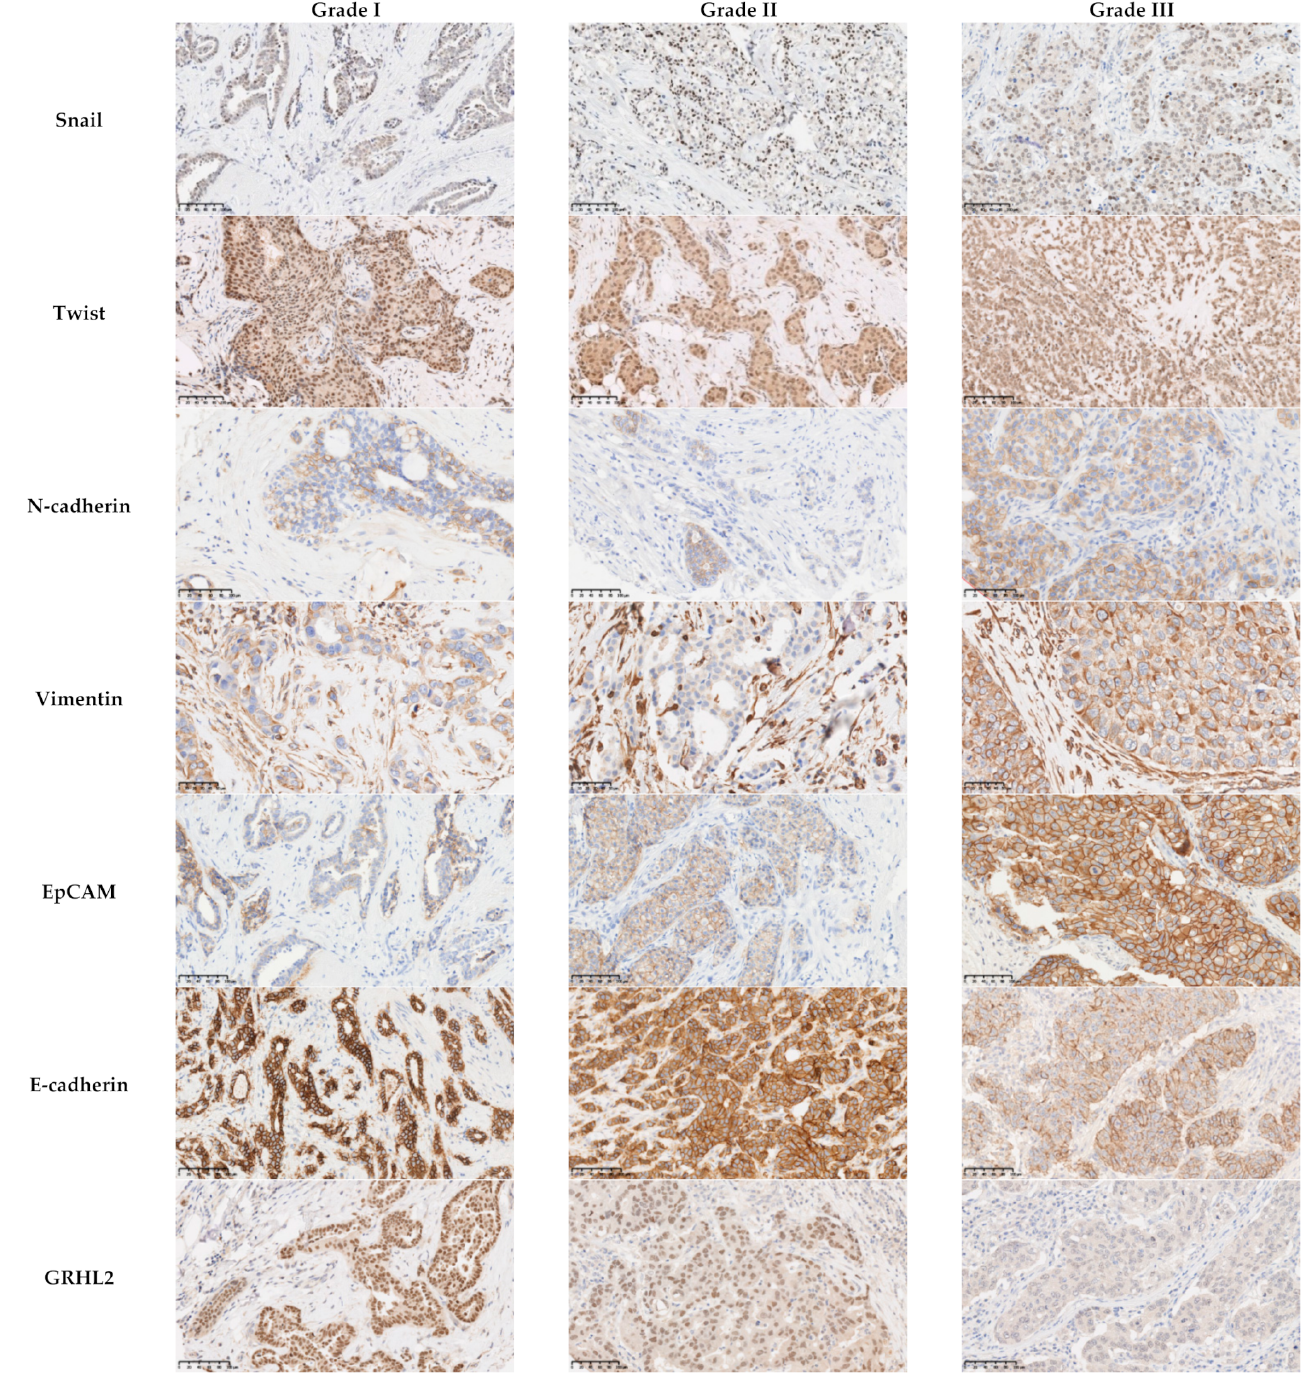
Figure 1. Association between the protein expression of EMT-related markers and the histological grade.There was no association between the level of expression of the mesenchymal markers Snail ( p = 0.149) and Twist (p = 0.38) and the histological grade. The mesenchymal markers N-cadherin and Vimentin and the epithelial marker EpCAM were overexpressed in grade III carcinomas ( p = 0.033, p < 0.0001, and p < 0.001, respectively). The reduction in the expression of E-cadherin was more often observed in grade III carcinomas ( p = 0.001). All the cases with a low or negative expression level of GRHL2 were grade III ( p = 0.001). Scale bars: 100 µ